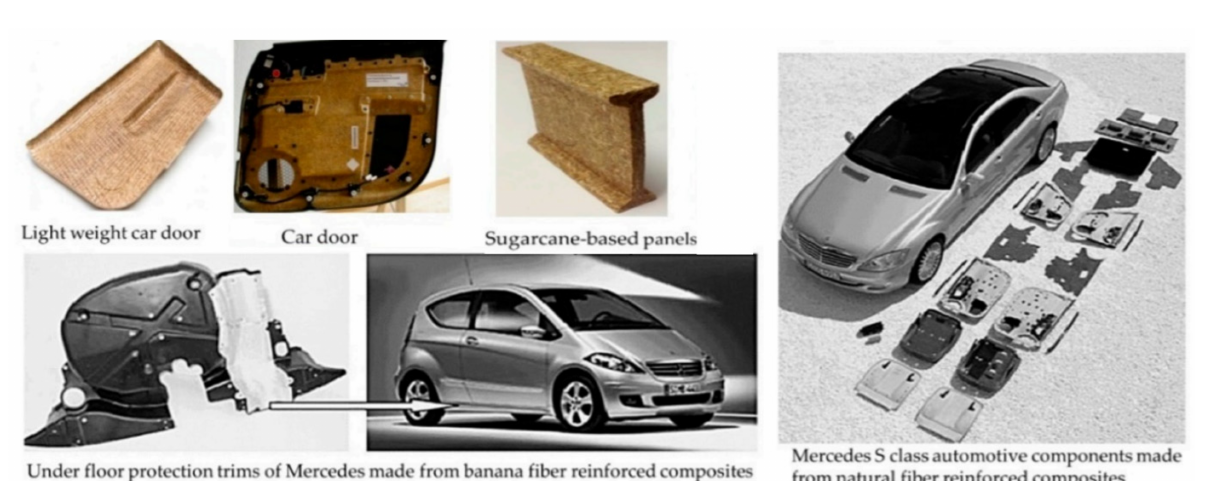
Figure 16. Natural fibers composites as automotive components. Reproduced from ref.